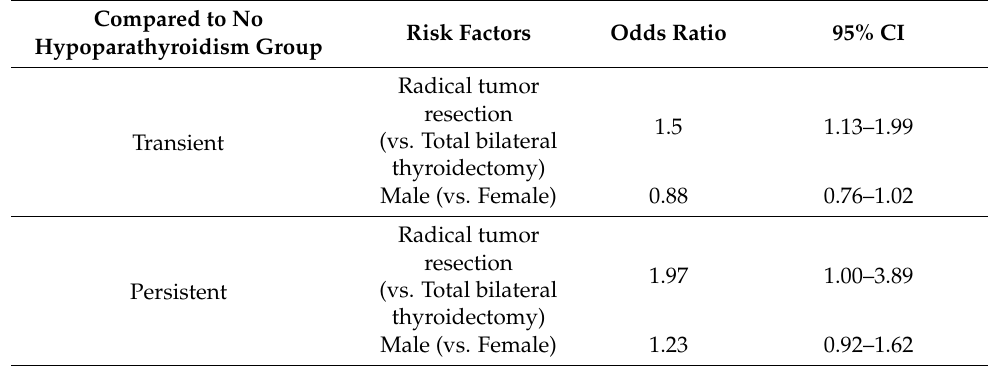
Table 3. Multivariate Logistic Analysis of Risk Factors for Transient and Persistent Hypoparathy- roidism Compared to the No Hypoparathyroidism